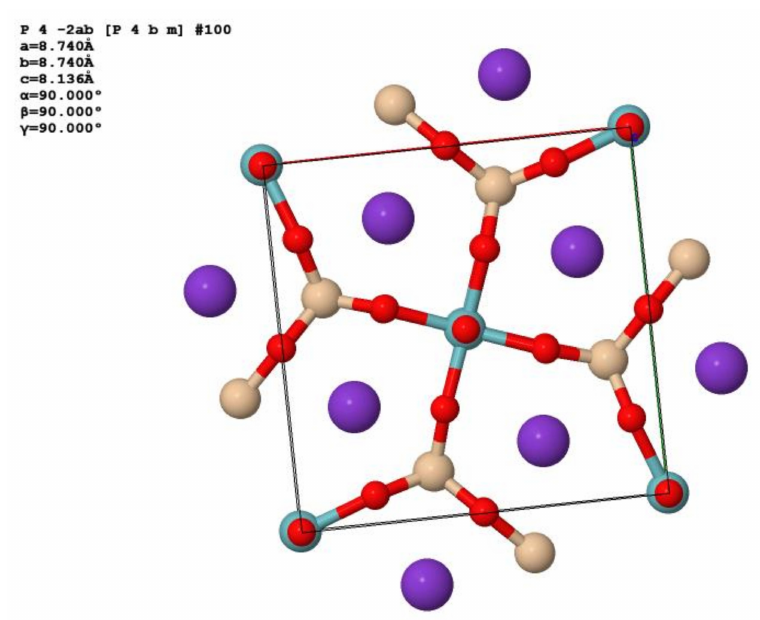
Figure 15. The crystal structure of the synthetic K 2 (NbO) 2 Si 4 O 12 (KNbSi 2 O 7 )